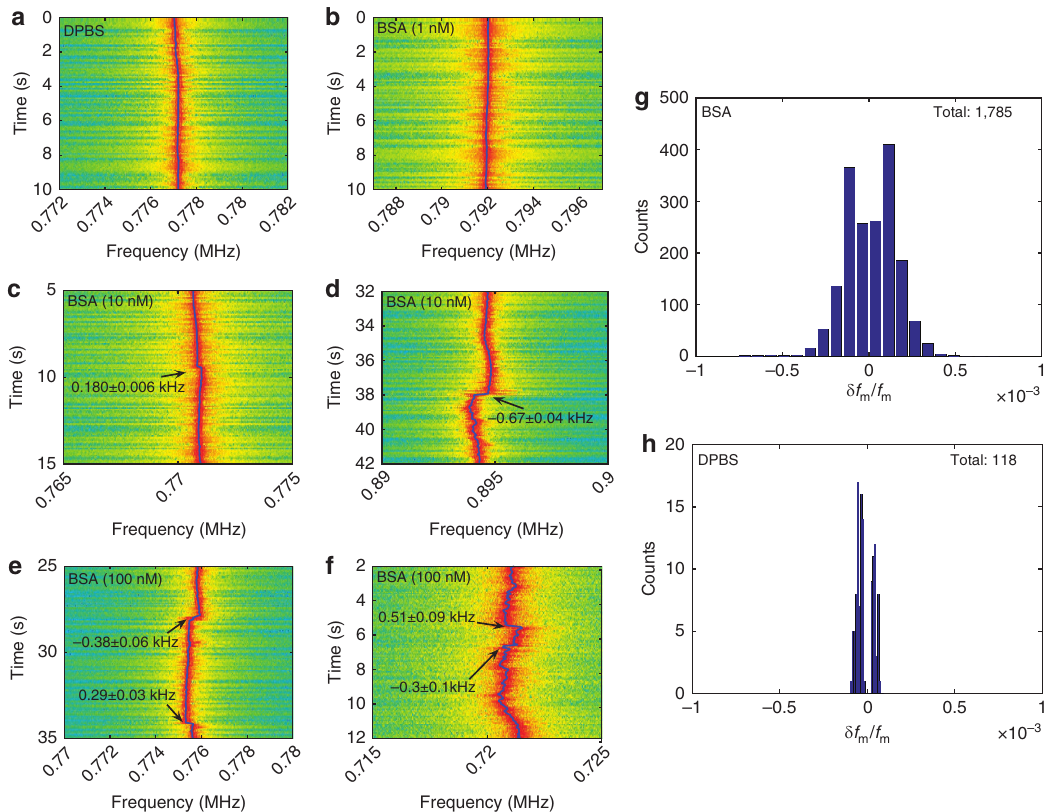
Figure 4 | Detection of single protein molecules. ( a – f ) Typical mechanical spectrograms recorded at the third harmonic of the oscillation tone with different BSA concentrations. ( a ) Bare DPBS environment where protein molecules were absent. ( b ) BSA molecules with 1nM nominal concentration were gradually injected. These two spectrograms show no binding event. ( c , d ) BSA molecules with 10nM nominal concentration were injected. The spectrograms capture the event of a BSA protein molecule binding at an off-equator site at 9.4s with a clear frequency step of 180 ± 6Hz ( c ), and that of a molecule detaching from the silica microsphere surface at 38s with a clear frequency step of (cid:3) 670 ± 40Hz ( d ). ( e , f ) BSA molecules with 100nM nominal concentration were injected. The spectrograms further show the corresponding binding events with increased binding frequency as well as background noises. ( g ) The histogram of the normalized frequency steps of BSA binding events. ( h ) The histogram of the normalized frequency steps in the bare DPBS environment where BSA molecules were